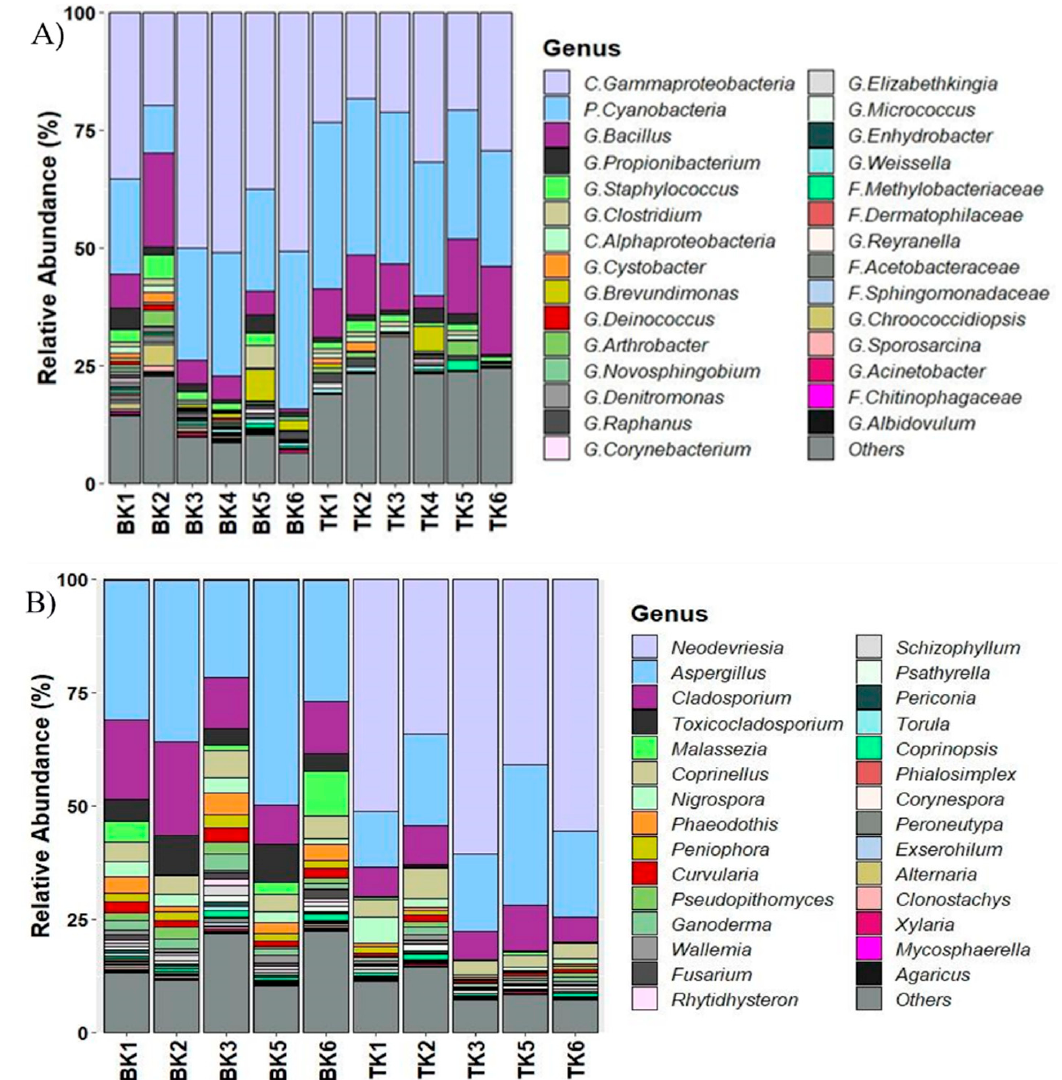
Figure 4. Microbial community composition of bacteria ( A ) and fungi ( B ) from two mural paintings from Buak Krok Luang temple (BK) and Tha Kham temple (TK). The stacked bar-plots were derived from high-throughput sequencing data.